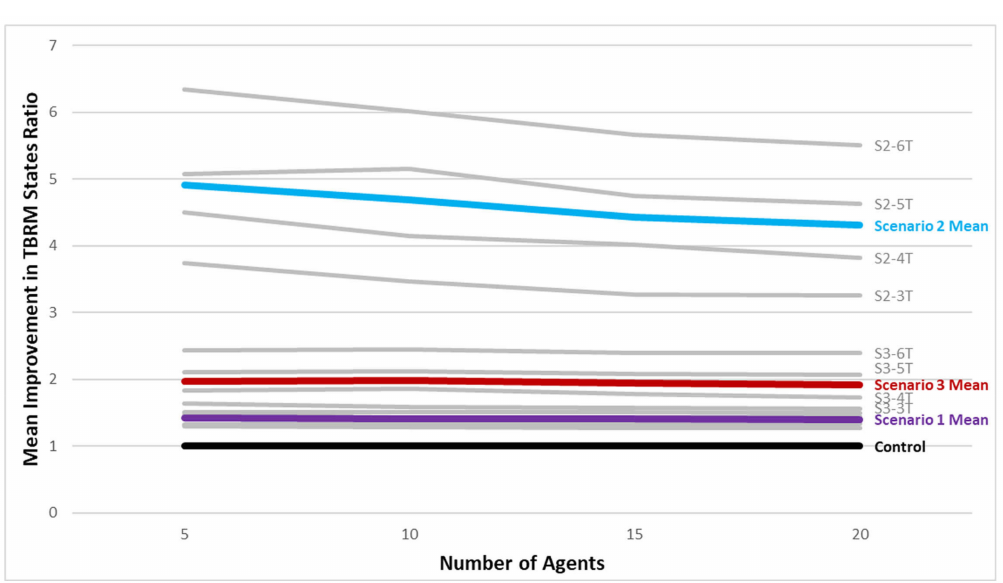
Figure 35. Mean results from each scenario in comparison with the control group with respect to the number of tasks in each MAS. Experiments with different agent configurations are shown in grey and labeled according to the scenario number and number of agents in each MAS. Individual experiments in Scenarios 1 and 3 are plotted but not labeled due to their close proximity to the respective scenario means.